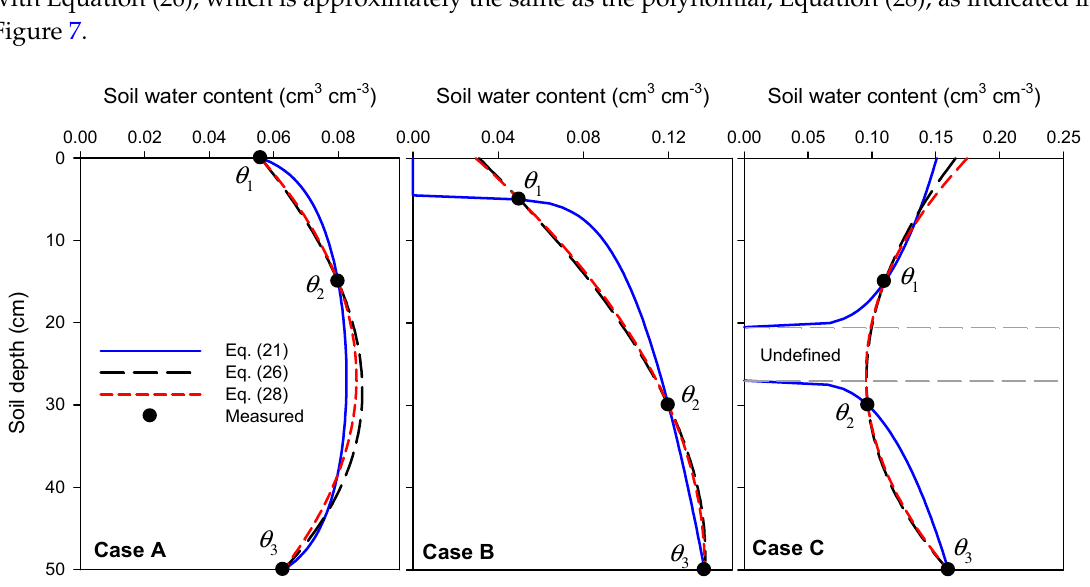
Figure 7. Three possible arrangements of θ 1 , θ 2 and θ 3 (model parameters) throughout the drying process. Data were extracted from Figure 13a in Tabatabaeenejad et al. [14]; profile 2 ( case A ), profile 6 ( case B ) and profile 4 ( case C ). Values of P = 6.6 and h cM = 87 cm were assumed.